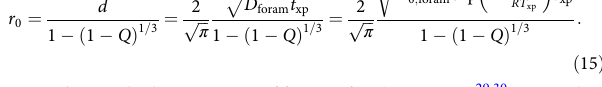
ffiffiffiffiffiffiffiffiffiffiffiffiffiffiffiffiffi p D foram t xp